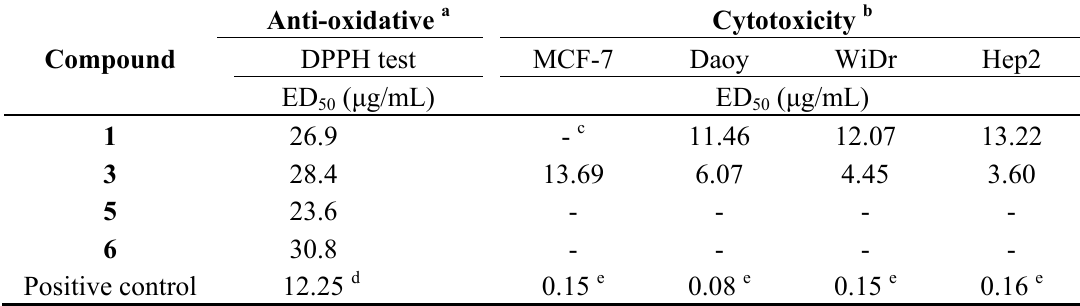
Table 3. Cytotoxicity and antioxidant scavenging effects of compounds 1 – 6 and 9 – 16 . Compound